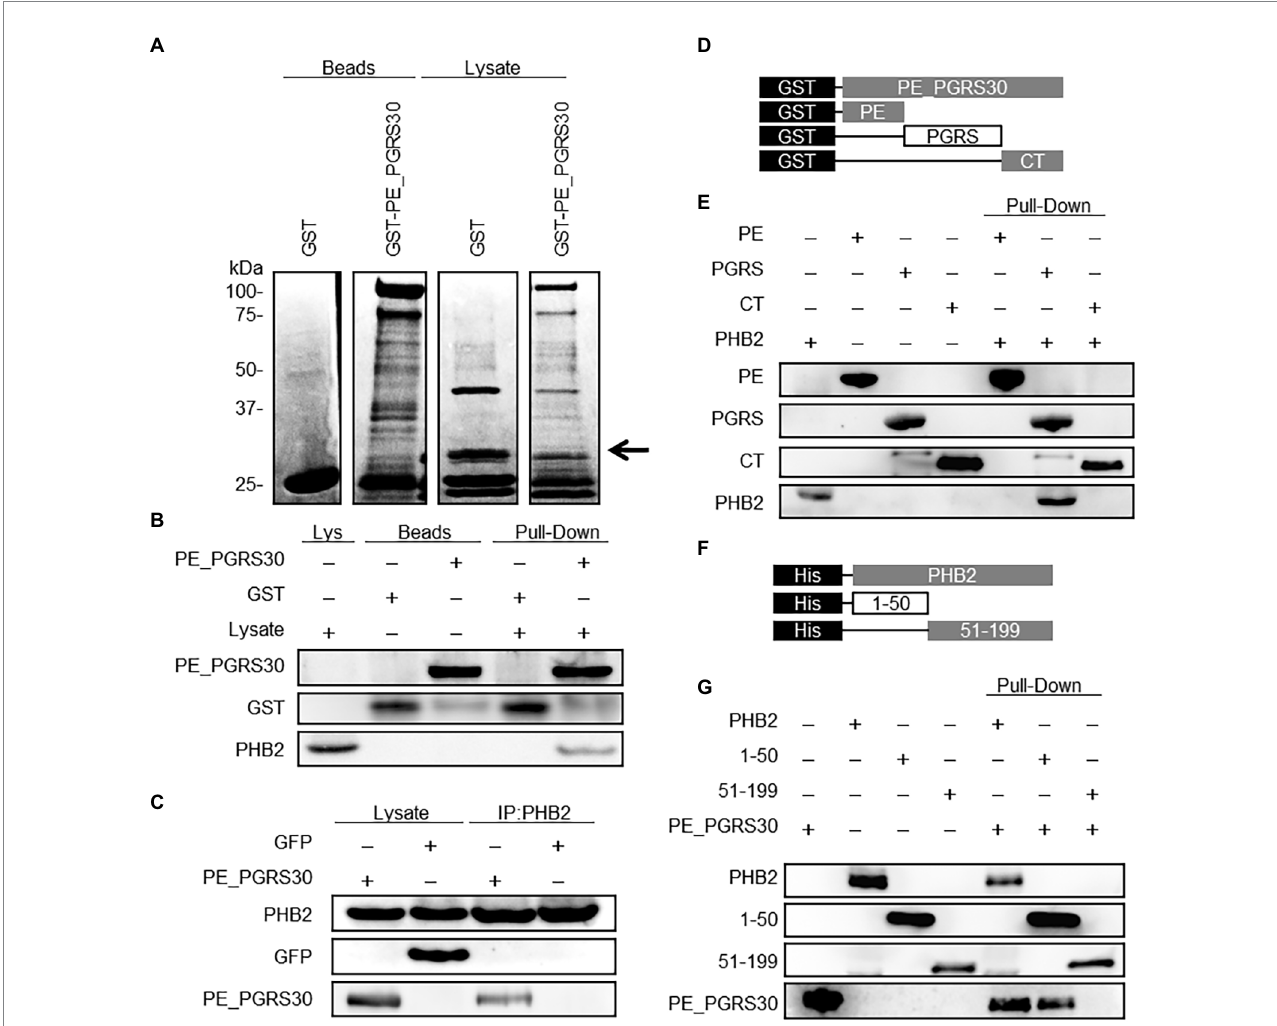
FIGURE 2 PE_PGRS30 binds to PHB2. (A) Host cellular proteins bound to PE_PGRS30. GST-PE_PGRS30 fusion protein or control GST were coupled to beads and incubated with whole cell lysates prepared from RAW264.7 cells. Beads (left 2 lanes) or cell-derived proteins bound to beads (lysates, right 2 lanes) were separated by SDS-PAGE and stained with Coomassie Brilliant Blue. A pulled-down protein (arrow heads) with molecular mass of 33 k Da was excised from the gel and subjected to mass spectrometry (nano-LC–MS/MS), and identified as PHB2 (association number, NP_031557). (B) Pull-down assay. GST-PE_ PGRS30-or GST-coupled beads were mixed with whole cell lysates of RAW264.7 cells. The lysate (Lys), beads, and the pulled-down proteins were immunoblotted with anti-GST and anti-PHB2 antibodies. (C) RAW264.7 cells were transfected with PE_PGRS30-Myc and control GFP expression vector as in Figure 1A, and the lysates were immunoprecipitated with anti-PHB2 antibody, then immunoblotted with anti-Myc-tag or anti-GFP antibodies. (D,E) Schematic representation of PE_PGRS30 mutants used in this study. PE, PGRS or CT domain fused with GST at the N-terminus were coupled to beads, then mixed with recombinant His-PHB2 in 0.1% HNTG buffer. Proteins pulled-down with the beads were separated and immunoblotted with anti-GST and anti-PHB2 antibodies. (F,G) Schematic representation of deletion mutants of PHB2. N-terminal region (amino acids 1–50) or C-terminus region (amino acids 51–299) fused with a His-tag at the N-terminus were generated and the recombinant proteins purified, mixed with GST-PE_PGRS30 in 0.1% HNTG buffer, and the bound pulled-down proteins were immunoblotted with anti-His and anti-GST antibodies. (A–G) Data are representative of two independent